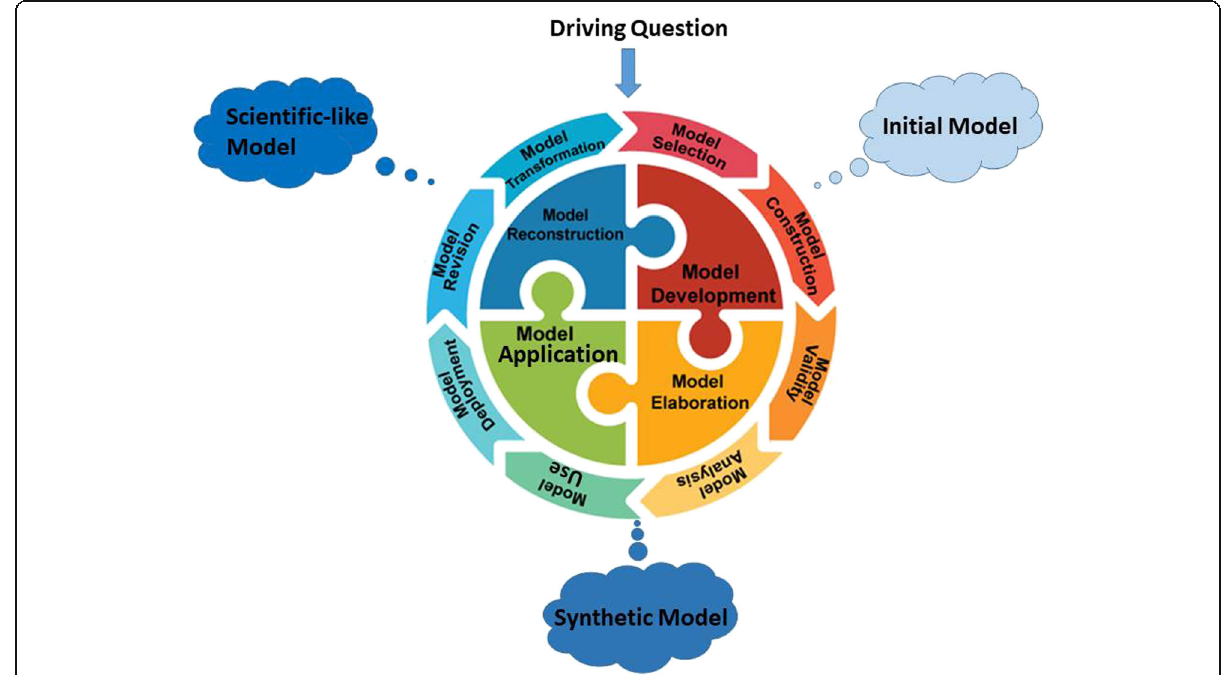
Fig. 3 The DEAR cyclic model on modeling